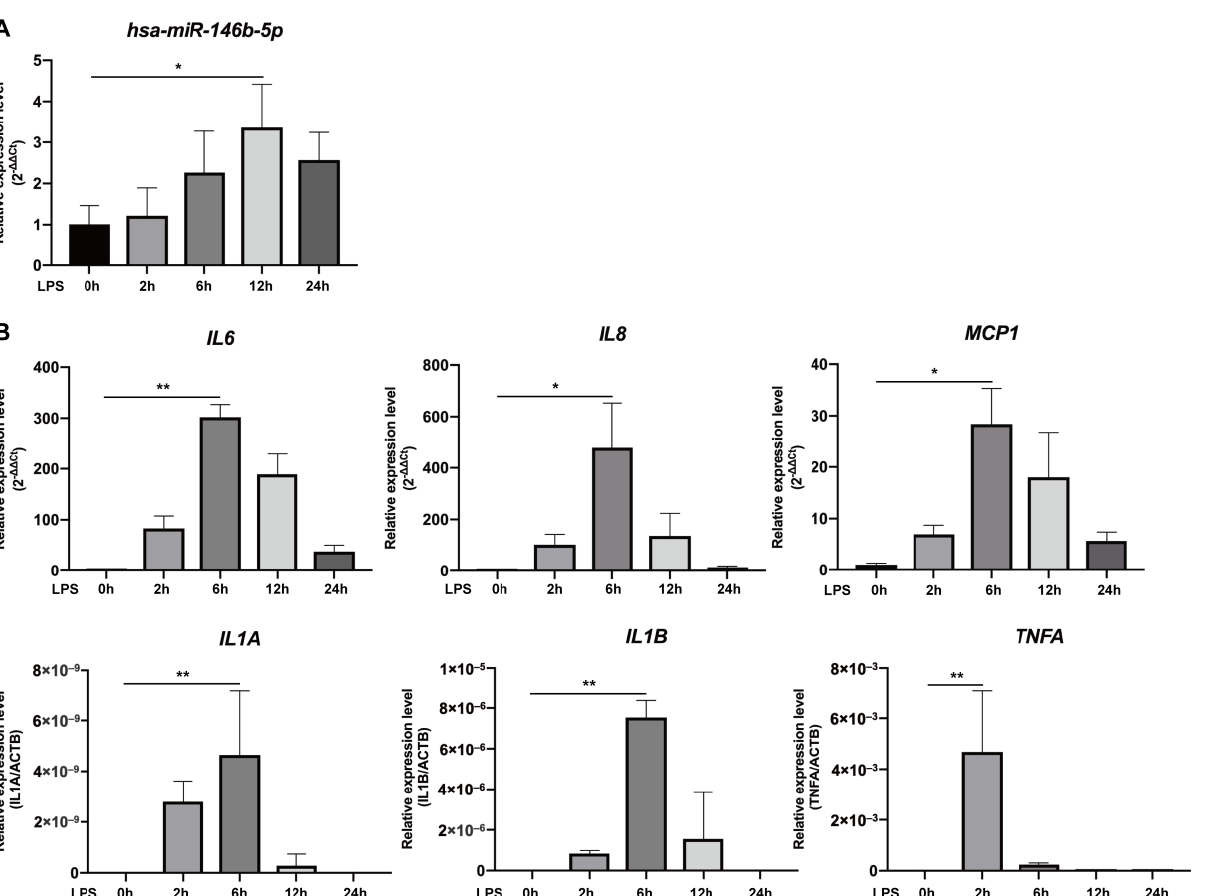
Figure 1. Expression of hsa-miR-146b-5p and pro-inflammatory mediator mRNAs is up-regulated in LPS-stimulated hDPCs. ( A ) Expression of hsa-miR-146b-5p was induced in LPS-stimulated hDPCs and significantly up-regulated at 12 h after LPS stimulation (mean ± SD, n = 4). ( B ) mRNA expression of pro-inflammatory mediators was induced in LPS-stimulated hDPCs. mRNA expression of IL6 , IL8 , MCP1 , IL1A , and IL1B peaked at 6 h after LPS application. mRNA expression of TNFA peaked at 2 h after LPS application (mean ± SD, n = 4). * p < 0.05 and ** p < 0.01. LPS: lipopolysaccharide; hDPCs: human dental pulp cells.